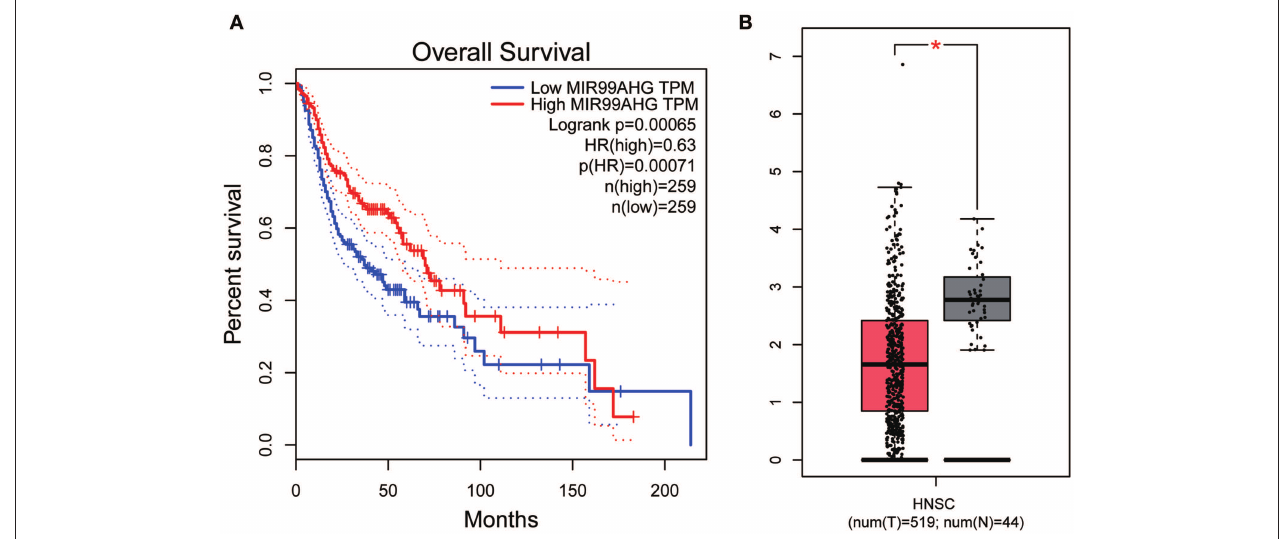
FIGURE 11 | Overall survival analyses and Gene expression difference analysis on MIR99AHG in the TCGA data set. (A) Kaplan-Meier curves of overall survival according to expression of MIR99AHG in TCGA-HNSC database. (B) Differentially expressed MIR99AHG in HNSC and normal tissues ( P < 0.05).